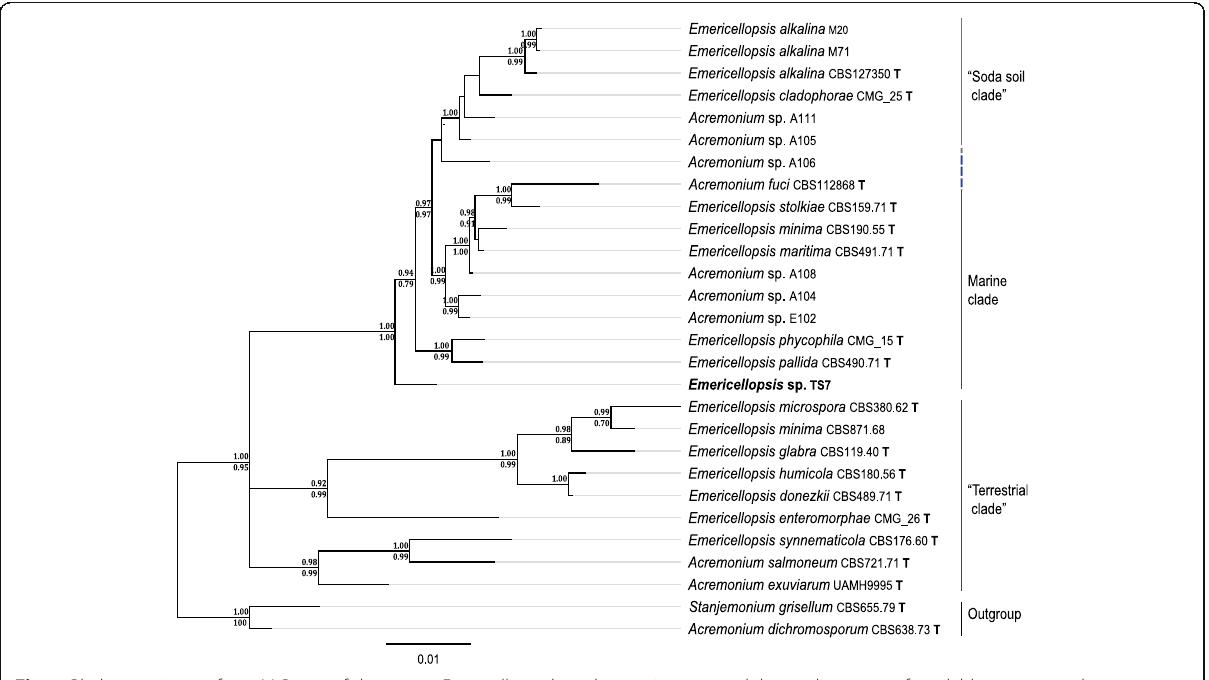
Fig. 1 Phylogenetic tree from MrBayes of the genus Emericellopsis based on a six gene multilocus alignment of available ex-type and representative sequences. Branch support values are from Bayesian posterior probability (top) and Maximum-likelihood aBayes support test (bottom). Branch length represents substitutions per sequence site. The taxon in bold is the studied fungus. The bold letter T denotes sequences of ex-type cultures. Accession numbers for each isolate are in Supplementary data 2, PhyML tree can be seen in Supplementary data